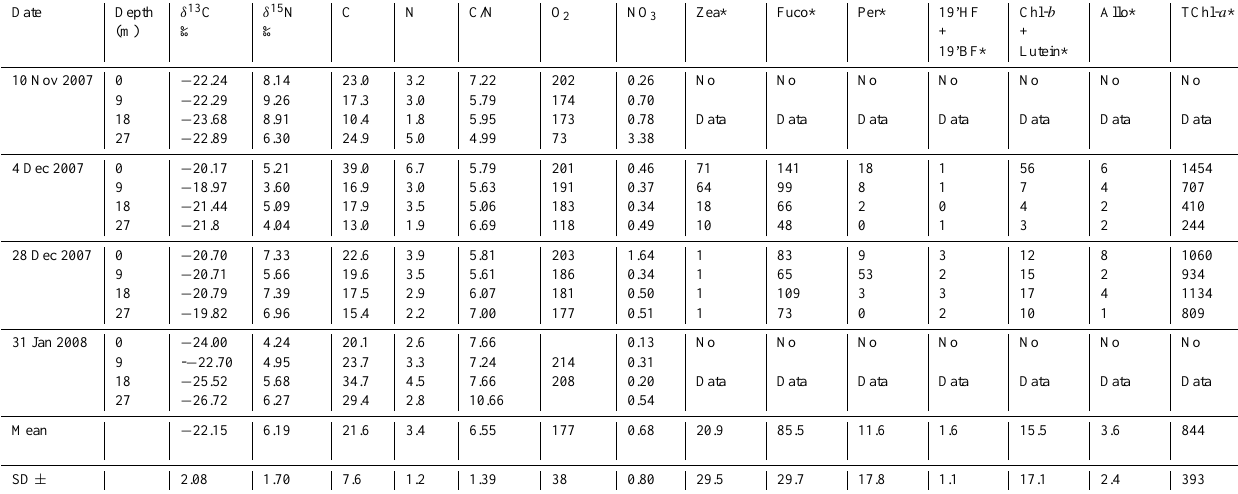
Table 3. Isotopic values ( δ 13 C and δ 15 N) of SPOM, their elemental C and N concentrations (µM), C/N ratios, O 2 , NO − pigment abundance (ngl − 1 ) during post-monsoon season at G5 station in the